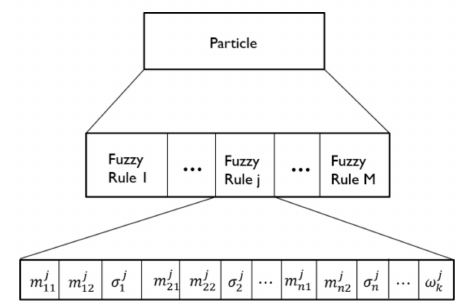
Figure 3. Coding diagram of